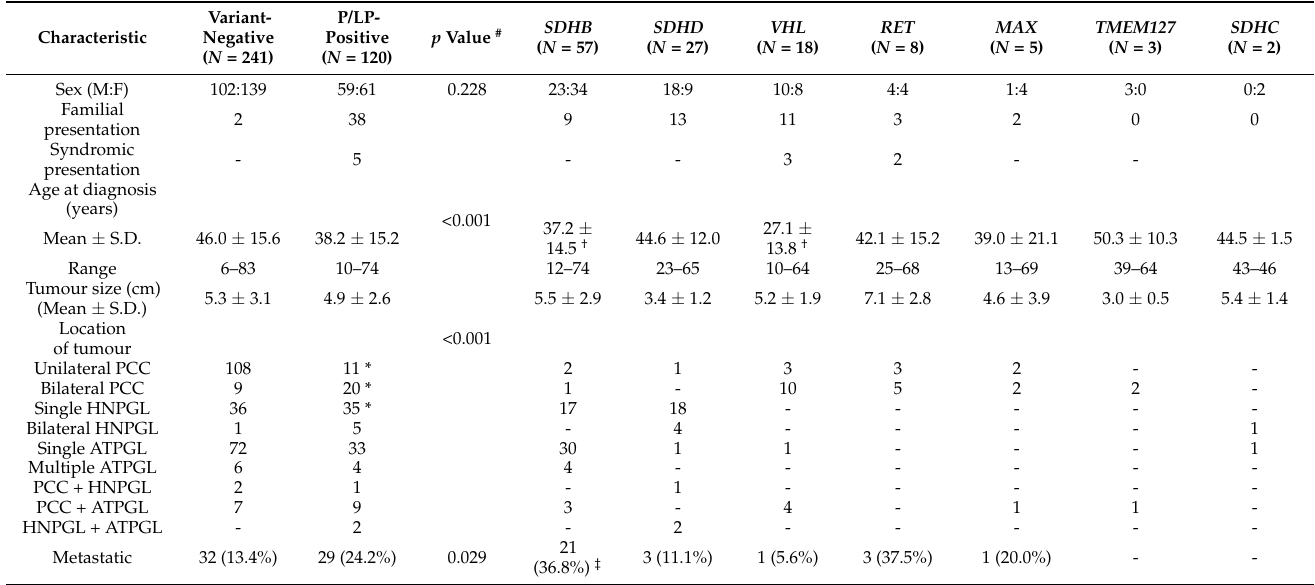
Table 3. Clinical phenotype based on the seven genotypes (excluding